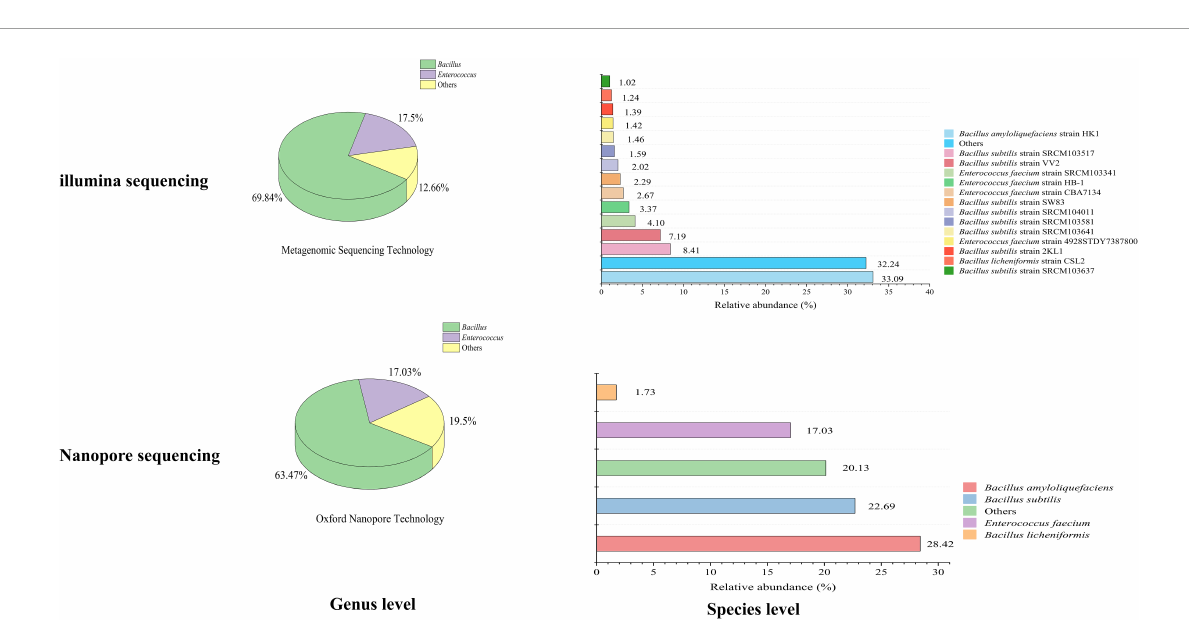
target pathogens listed in the standard could be